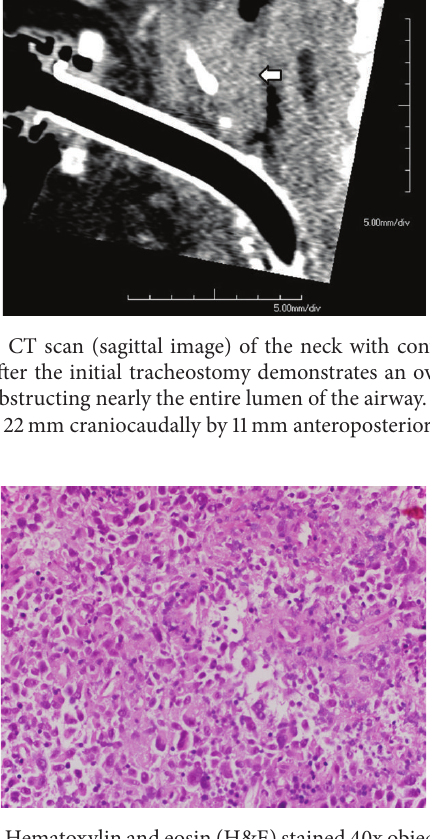
Figure 2: Hematoxylin and eosin (H&E) stained 40x objective pho- tomicrograph shows discohesive malignant neoplasm with enlarged hyperchromatic pleomorphic nuclei and eosinophilic nucleoli and surrounding pale cytoplasm.